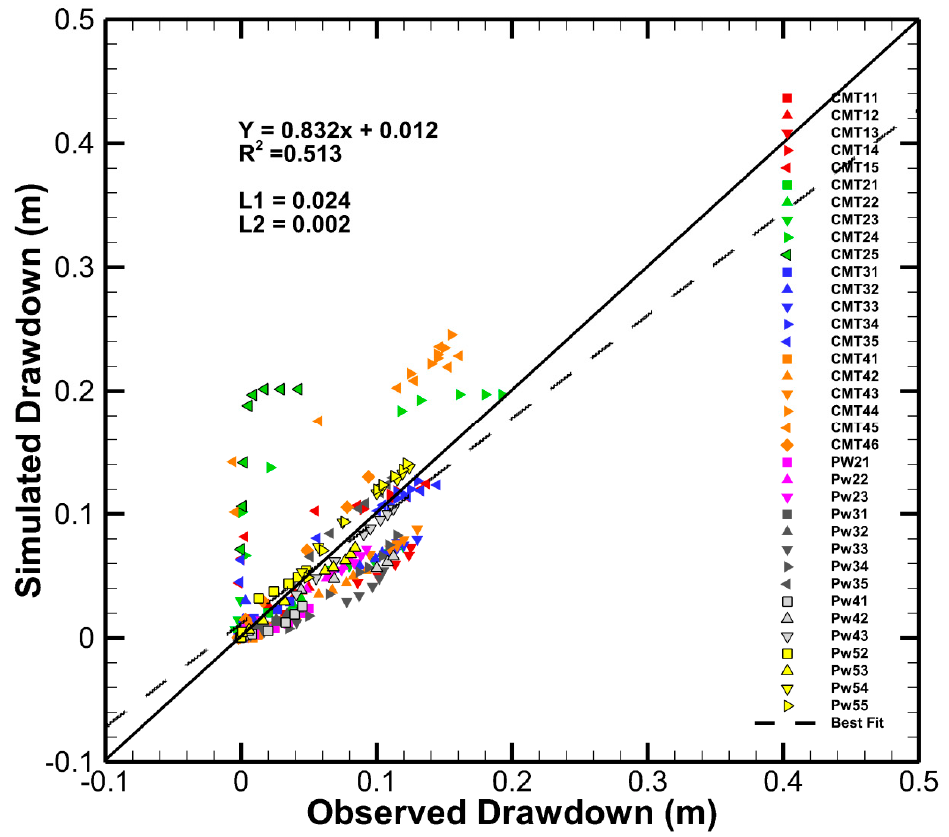
Figure 7. Validation scatterplot for different observation ports during pumping at PW1-5 using THT analysis results. The black solid line suggests a perfect 1:1 correlation, while the dashed line is the best-fit line. The linear fit results are also provided. L1 is the mean absolute error norm, and L2 is the mean square error norm, representing the correspondence between observed and simulated drawdowns.